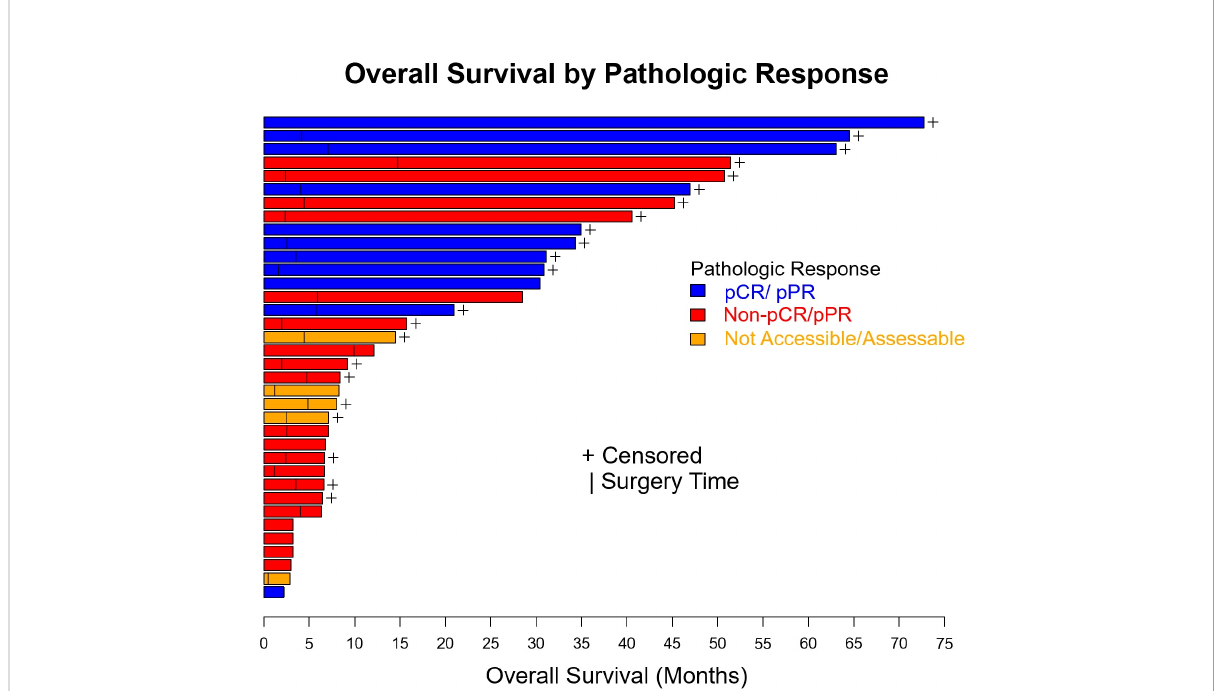
FIGURE 5 Swimmer plot of patients with resectable mucosal melanoma treated with neoadjuvant checkpoint inhibitors with pathologic response (blue), no pathologic response (red), and unknown pathologic response (orange). pCR, pathologic complete response, pPR, pathologic partial